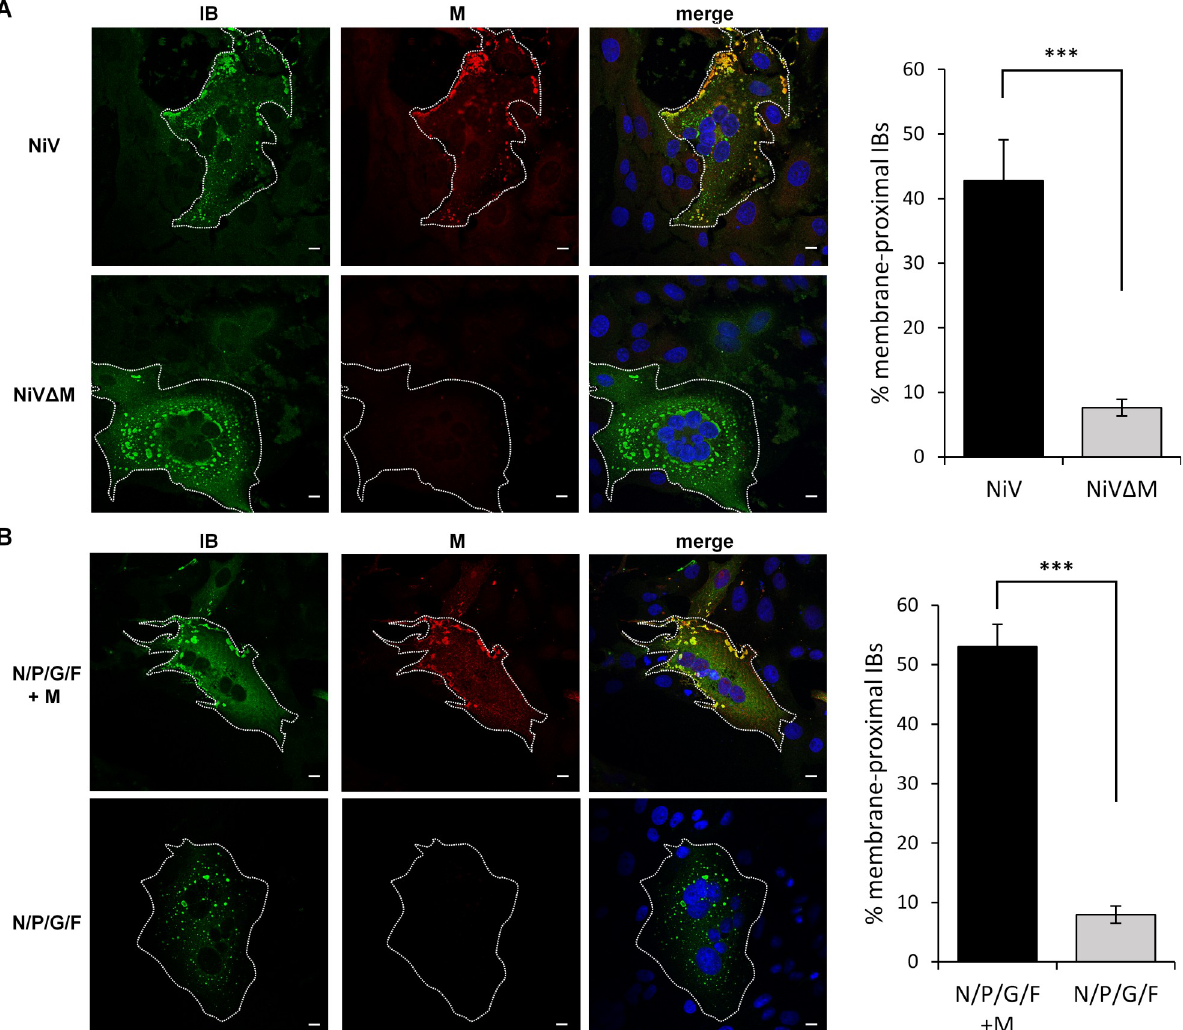
Fig 2. Colocalization of NiV M protein and inclusion bodies in NiV-infected and transfected cells. (A) Vero76 cells were infected with wildtype NiV and NiV Δ M at a MOI of 0.01 and 0.025, respectively. At 24 h p.i. cells were fixed with 4% PFA for 48 h and permeabilized with Triton X-100. Cells were incubated with a NiV N-specific guinea pig antiserum to visualize IBs (green). NiV M was detected with an M-specific rabbit antiserum (red). Nuclei were counterstained with DAPI (blue). Confocal xy sections of the central regions of syncytia are shown. White dotted lines indicate the lateral borders of syncytia. (B) Cells coexpressing the NiV proteins N, P, G and F in the presence (N/P/G/F + M) or absence of NiV M (N/P/G/F) were fixed and permeabilized with Triton X-100 at 24 h after transfection. Immunostaining was performed as described above. Scale bars, 10 μ m. In the right panels, quantifications of IB distribution in syncytia is shown. Using the automated ImageJ analyze particle tool, the total numbers of IBs and the number of IBs located at a maximum distance of 10 μ m from the lateral edge of the syncytium were counted in individual sections of 6–10 syncytia from three individual experiments. The average percentage of membrane-proximal IBs in syncytia in the absence and presence of M was calculated. Error bars indicate the standard error of the mean. Statistical significance is indicated by asterisks (unpaired t-test; ��� , p <